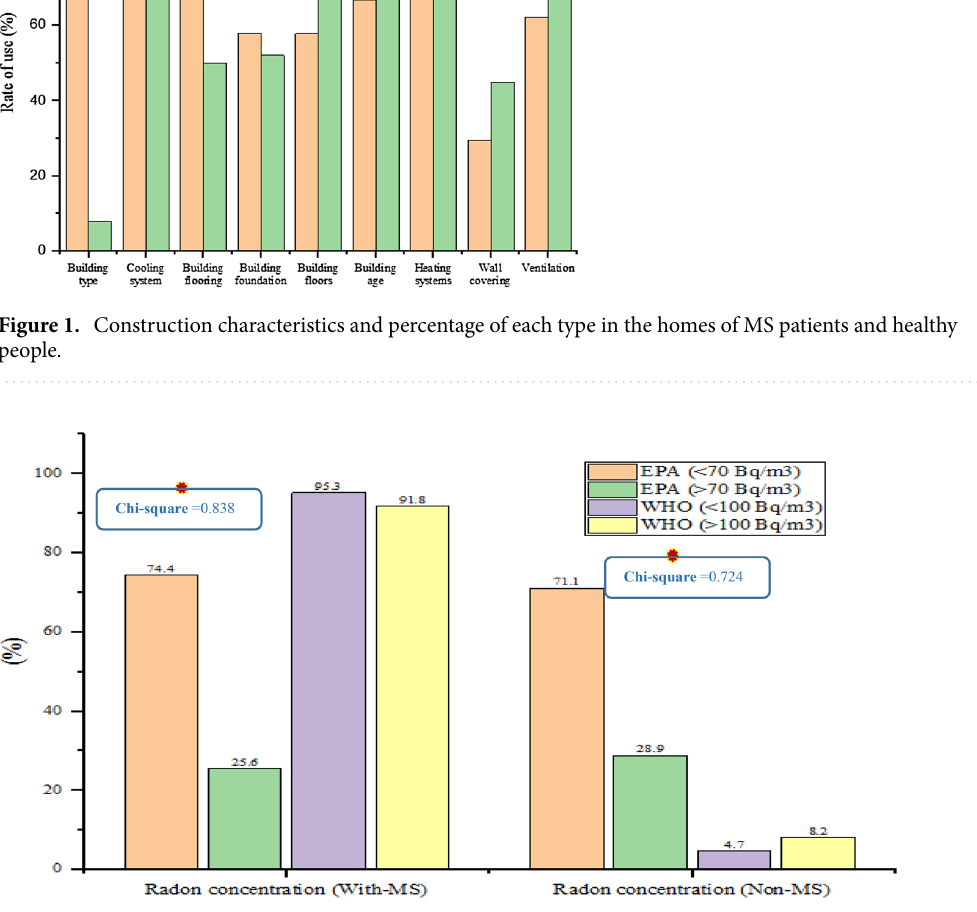
Figure 2. Total Rn gas concentration in comparison with EPA and WHO